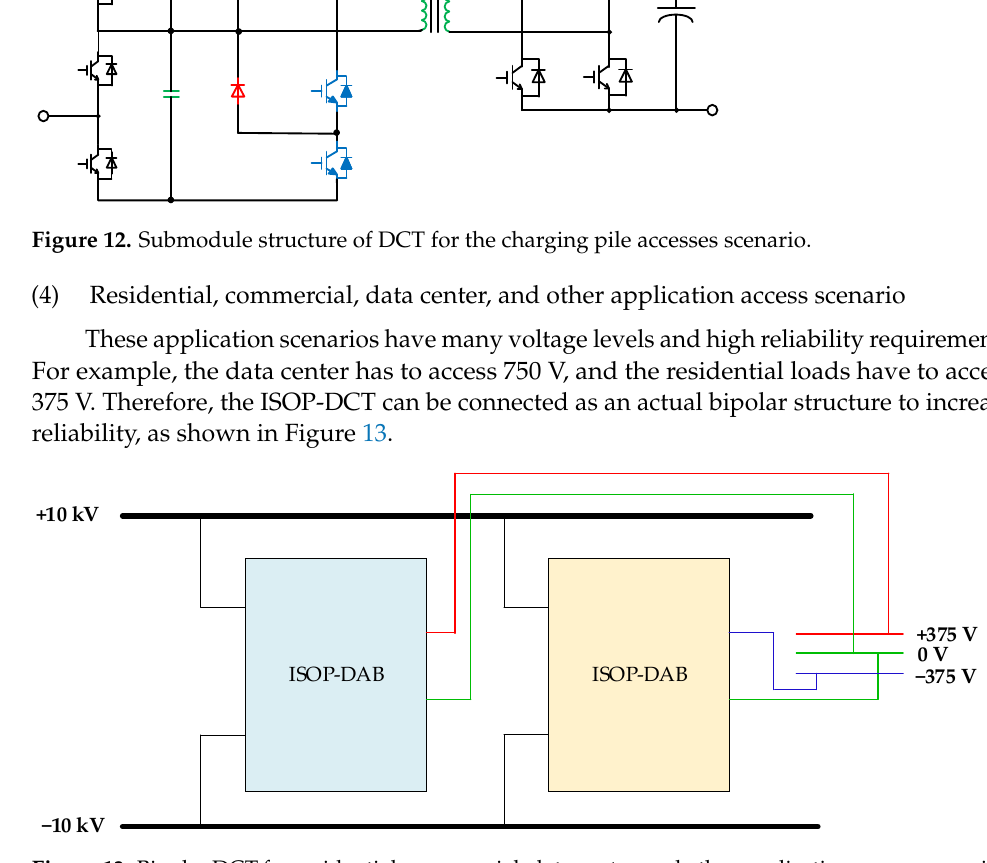
Figure 13. Bipolar DCT for residential, commercial, data center, and other application access scenar- ios.